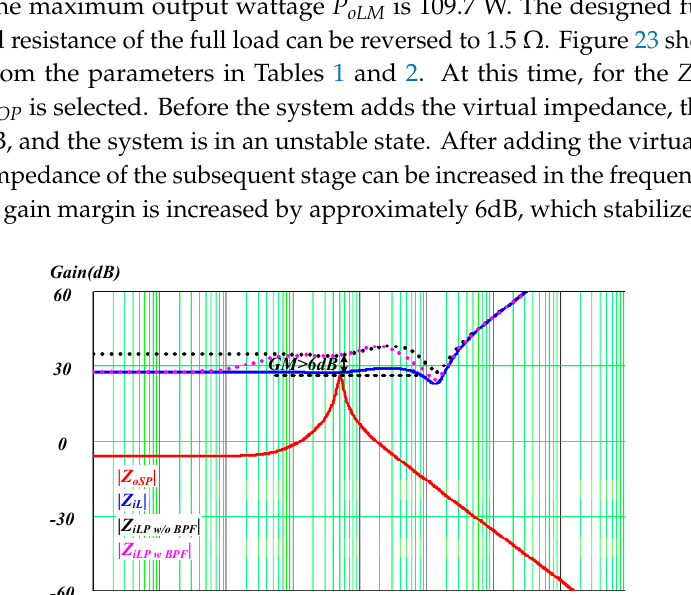
w/ Z PVI ( b ) Figure 24. System waveform before and after adding virtual impedance ( a ) simulation results ( b ) actual measurement results (scale v BUS [Ch1]: 50V/div; i O [Ch2]: 5A/div; v O [Ch3]: 20 V/div; time: 1 ms/div). To measure the effect of different Z PVI on the overall output impedance, we switch the band-pass filter to a high-pass filter to increase the output impedance’s observable range. It can be inferred from Equation (28), and Z PVI is designed with the load resistance of R L = 1.5 Ω , then, Z PVI = Z PVIFL = 56 Ω . Z PVI is set to Z PVI = Z PVIOP = 42 Ω and Z PVI = Z PVIFL = 56 Ω , respectively. Two feedforward designs are placed into the system. The input voltage source is Chroma 62150H-1000. The spectrum analyzer NF FRA5096 is used with the electronic load Chroma 63204 to scan the overall output impedance of the